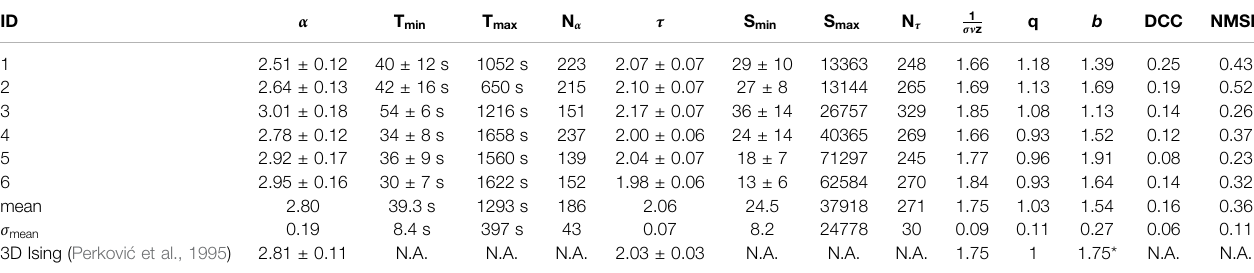
TABLE 1 | Table of exponents calculated from analysed